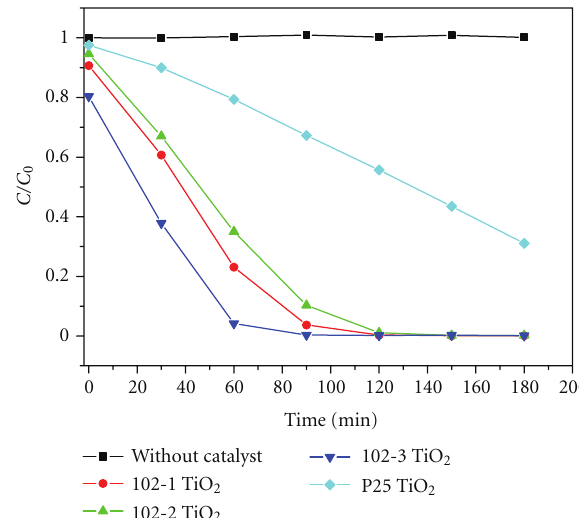
Figure 5: RhB concentration changes during the photodegradation of RhB. C 0 is the initial RhB concentration before adsorption to the TiO 2 surfaces, and C is the temporal concentration of RhB after equilibrium